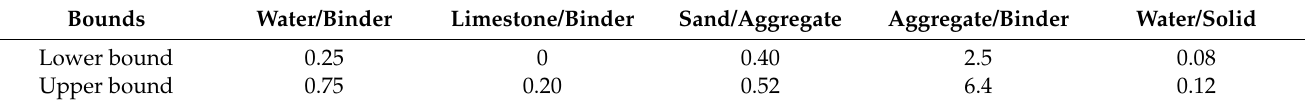
Table 3. Restraint of constituent